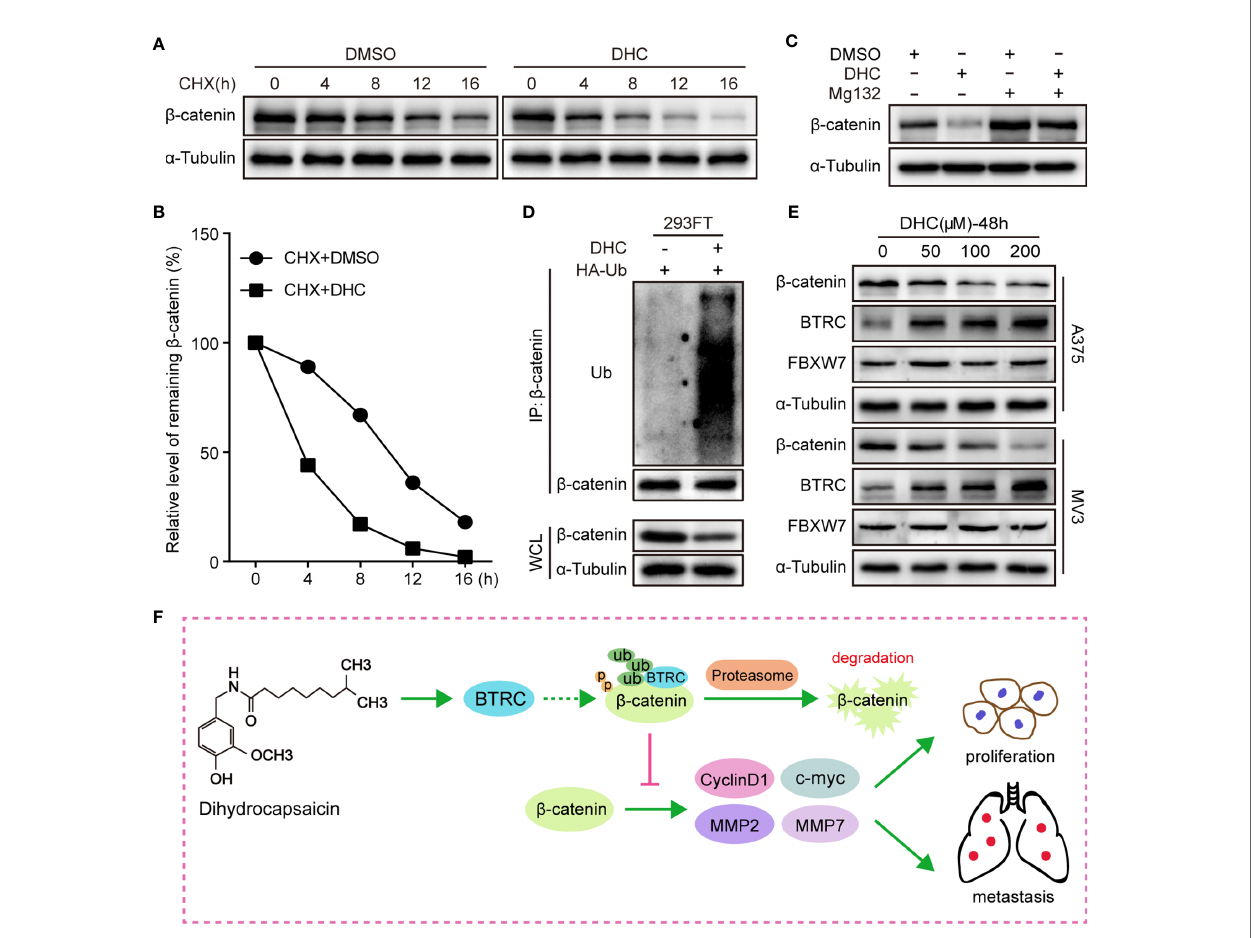
FIGURE 7 | DHC down-regulates b -catenin by increasing its ubiquitination. (A, B) The protein turnover rate of b -catenin in A375 cells under the treatment of 100 m M DHC. (C) The protein expression of b -catenin in 100 m M DHC or DMSO treated cells in the presents or absents of MG132. (D) Ubiquitination levels of b -catenin was detected in HA-Ub transfected 293FT cells after treatment with DHC. (E) The expression of BTRC and FBXW7 in A375 and MV3 cells treated with 0, 50, 100, and 200 m M of DHC for 48 h. (F) Model of the impact of DHC on melanoma cells by the regulation of b -catenin signaling pathway was